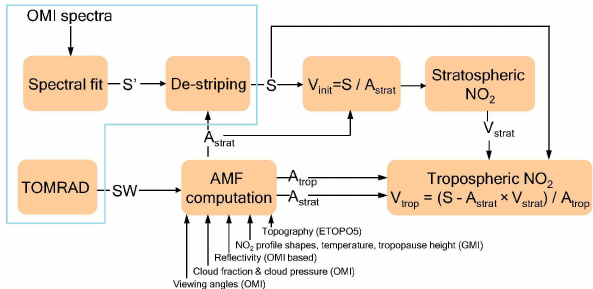
Fig. 1. Flow diagram of retrieval algorithm for stratospheric and tro- pospheric NO 2 columns. S , V , A , and SW represent slant-column density, vertical-column density, air mass factor, and scattering weight ( m ), respectively. The section outlined in blue is OMI- specific. TOMRAD is a forward vector radiative transfer model (Davé,